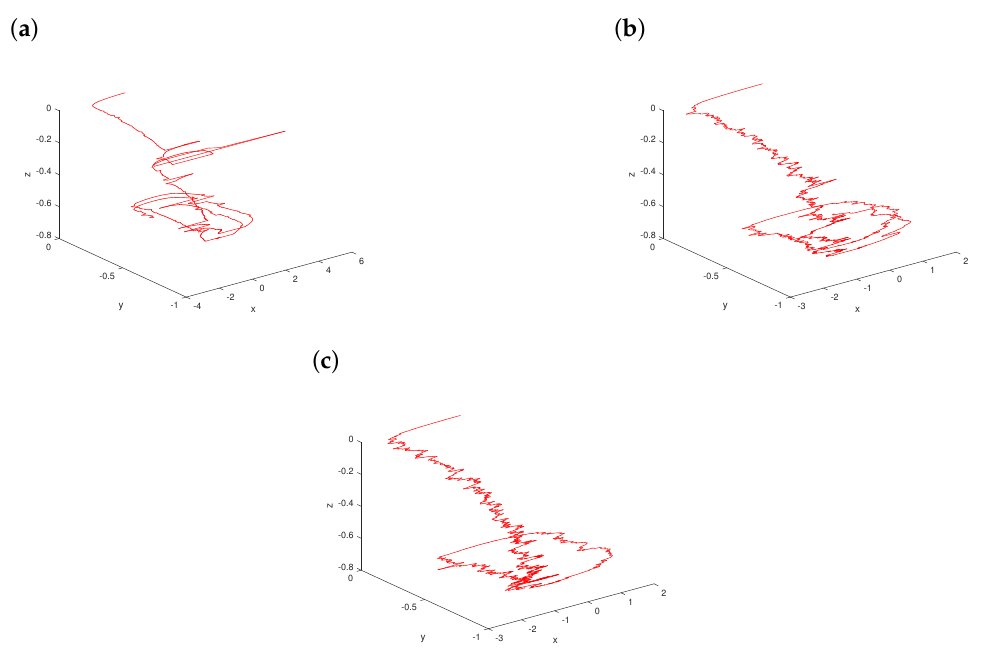
Figure 4. When x ( 0 ) = y ( 0 ) = z ( 0 ) = 0 and (cid:101) = 0.1: ( a ) dynamical trajectory of system (12); ( b ) quasiperiodic behaviors for the three variables x ( t ) , y ( t ) , and z ( t ) in system (12). It can be discerned from Figure 5a that the intermittency is present in the path of stochastic Koper system (11) with α = 0.8 , which can lead to extremely complex random behavior. When α = 1.6 , the trajectory of system (11) goes through a stochastic regime with an irregular pattern observed in Figure 5b. As the stability index gets large, system (11) forced with noise is structurally unstable. The quasiperiodic behavior is interrupted by occasional stochastic bursts. This complication is confirmed in Figure 5c for α = 1.9 .